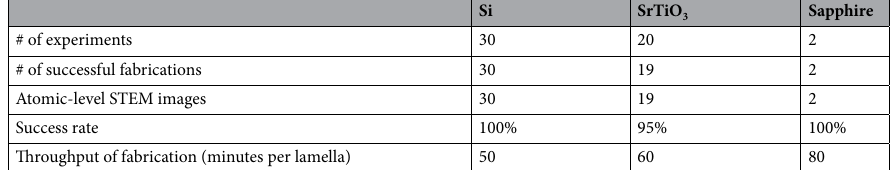
Table 1. Summary of the robotic FIB experiments. The number of experiments includes preliminary tests of fabricating lamellae to explore FIB parameters. The successful fabrication counts the number of the experiments that completed all the automation processes (including 2 kV-FIB polishing). One fabrication of SrTiO 3 lamella failed in the lift-out process. All the lamellae in “successful fabrications” were evaluated by STEM and yielded atomic-level STEM images. Throughput of fabrication is the duration that the automation software spent in rough-milling, lift-out, and the final-thinning processes of each STEM sample. This value is a typical one and excludes the processing time of loading bulk samples and setting the automation